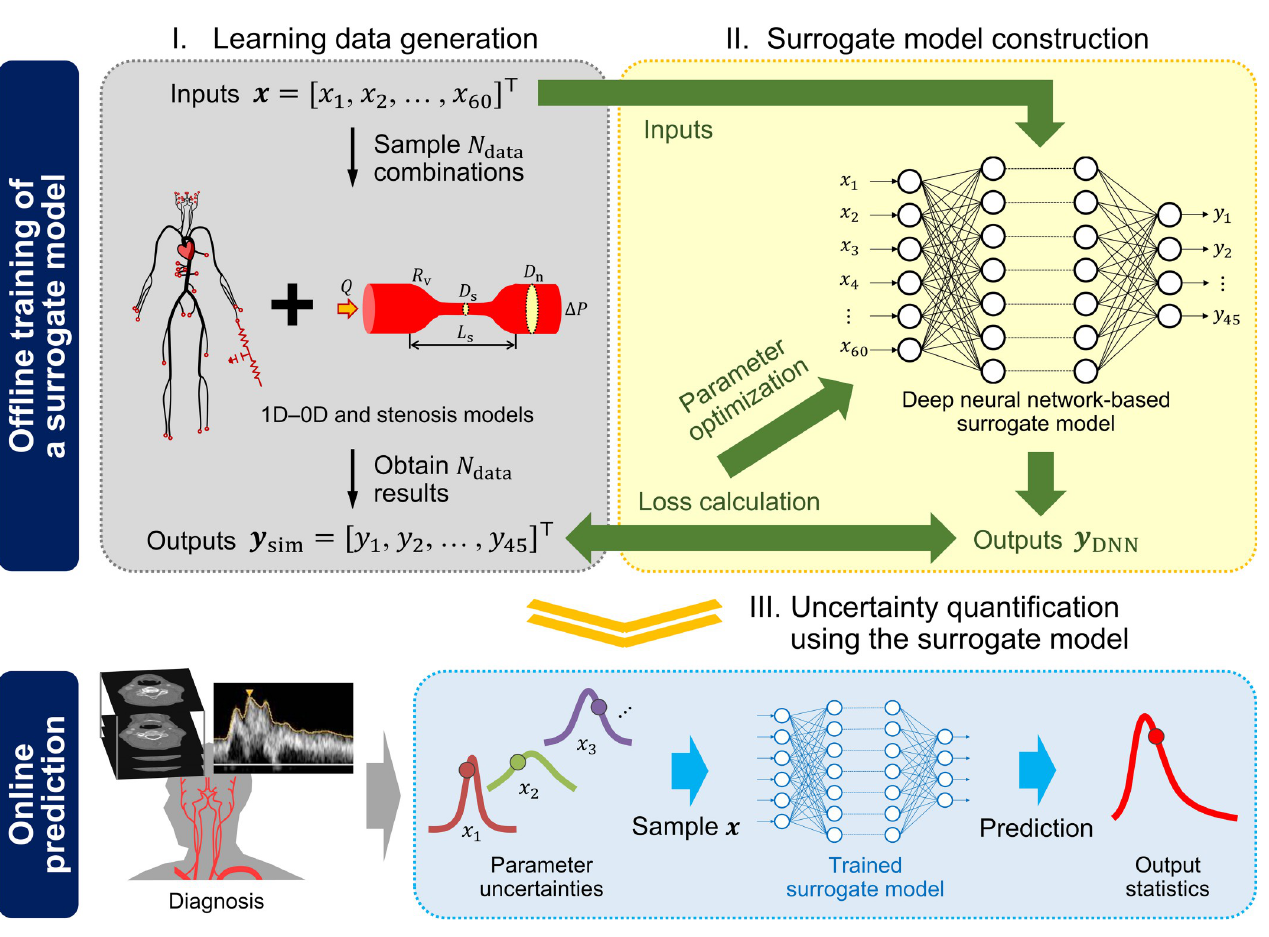
Fig 1. Overview of the proposed approach to perform uncertainty quantification. We trained a deep neural network using the datasets obtained from one- dimensional–zero-dimensional (1D–0D) simulation. The datasets were generated by randomly sampling 60 inputs (column vector x 2 R 60 ) describing the geometry of cerebral arteries and stenoses, and collecting the corresponding 45 simulation outputs (column vector y sim 2 R 45 ) of time-averaged flow rates and pressures. After performing the data acquisition and model training in the offline phase, the surrogate model was used in the online phase to predict the outputs rapidly. This ensured a fast and efficient uncertainty